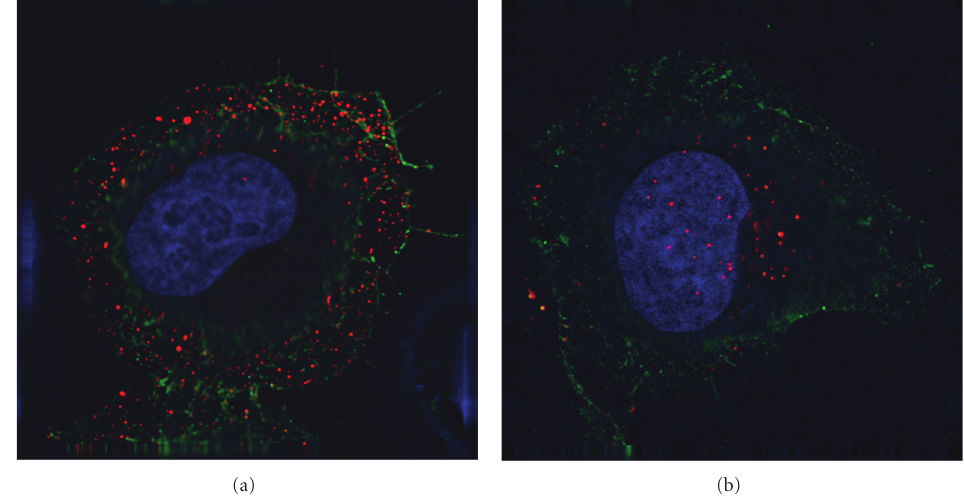
Figure 1: Internalisation of OxLDL. Epithelial HeLa cells transiently expressing a LOX-1-FLAG protein (green) were incubated with 10 μ g/mL DiI-OxLDL (red) for 5mins at 37 ◦ C (pulse) to allow binding (a), and chased for a further 55 mins to allow internalization (b) before fixation. Nuclei were stained with DAPI (blue). Specimens were visualized using a deconvolution microscope using previously described procedures [26].